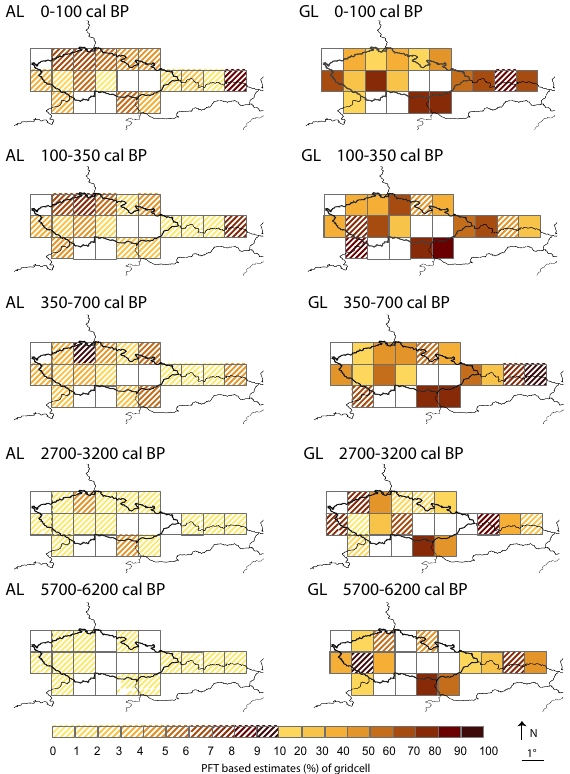
Fig. 11. REVEALS estimates of the two open-land plant functional estimates (PFTs), AL (agricultural land=cereals) and GL (grass- land=grasses and other herbs) for the Czech Republic at five time slices using the PALYCZ pollen database (Kuneˇs et al., 2009) and following the LANDCLIM project’s protocol. In this visualization of the results, the zero values (no occurrence of a PFT) are not dis- tinguised from values > 0% up to 1%. Note the distinct changes and the maintenance of spatial differences through time, e.g. the high representation of grassland in the South-East from 6000BP, and the higher representation of agricultural land in the North from 3000BP. A thorough discussion of these results will be published elsewhere (Mazier et al.,